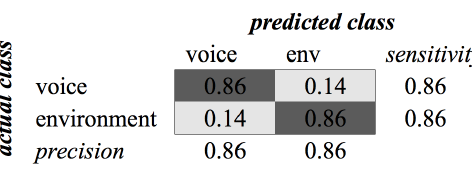
Figure A3. SVM confusion matrix of Environment/Voice classification for MFCC feature type.